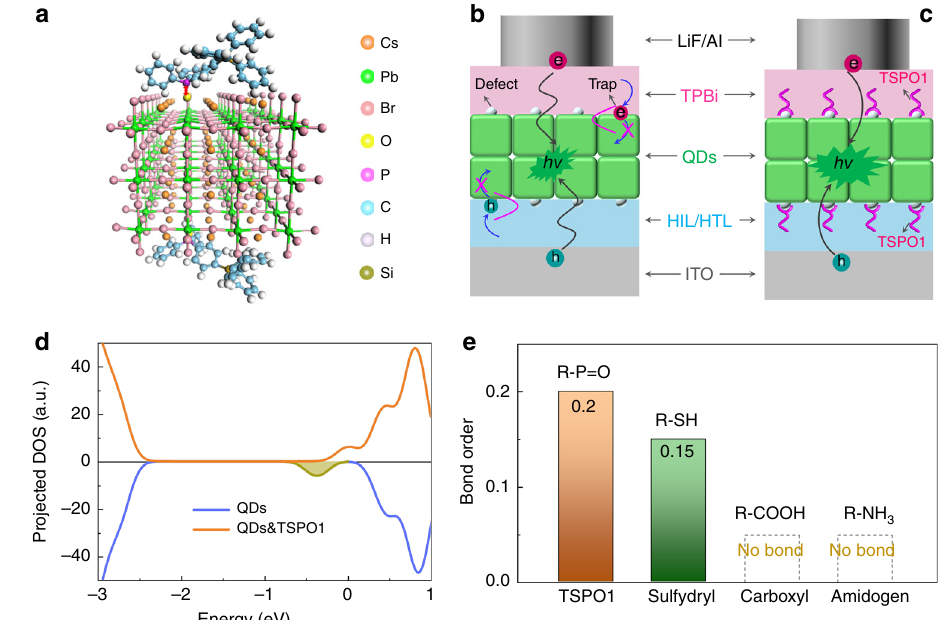
Fig. 1 The bilateral passivation strategy for ef fi cient and stable QLEDs. a Diagram of the interaction between TSPO1 and perovskites. The red double- headed arrow show that the TSPO1 group has interaction with the uncoordinated Pb atom. The structure of QLED based on QD fi lms passivated without ( b ) and with passivation ( c ), schematic illustration that TSPO1 could passivate defects on the surface of QD fi lms, the defects may trap carriers (e.g. holes, electrons), decrease exciton recombination, and hence degrade the device performances. d DOS of the perovskite surface passivated with and without passivation. e Calculated bond order of surface Pb atom with TSPO1, sulfydryl, carboxyl, and amidogen ligands respectively. Source data are provided as a Source Data fi Supplementary Fig. 1. The DOS of the unpassivated surface showed signi fi cant trap states on the band edge, which is due to the non-coordinating Pb atom. While, the trap states in QD fi lms after passivating by TSPO1 was greatly weaken, which indicated the TSPO1 could effectively passivate defects, eliminate the trap states, and prevent the trapping of carriers.